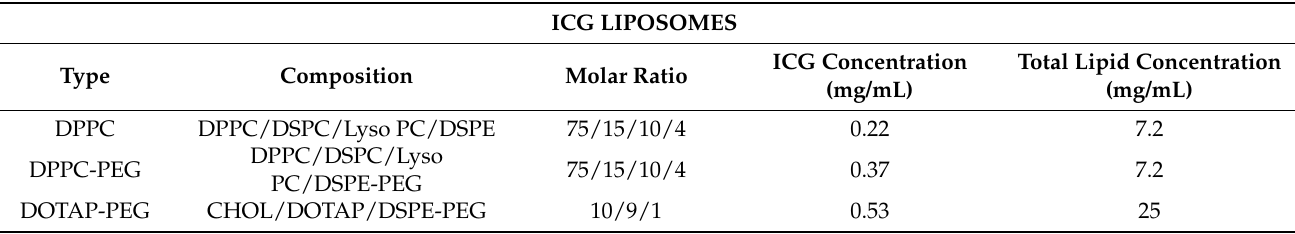
Table 1. Composition, molar ratios and starting concentrations of ICG liposomes.